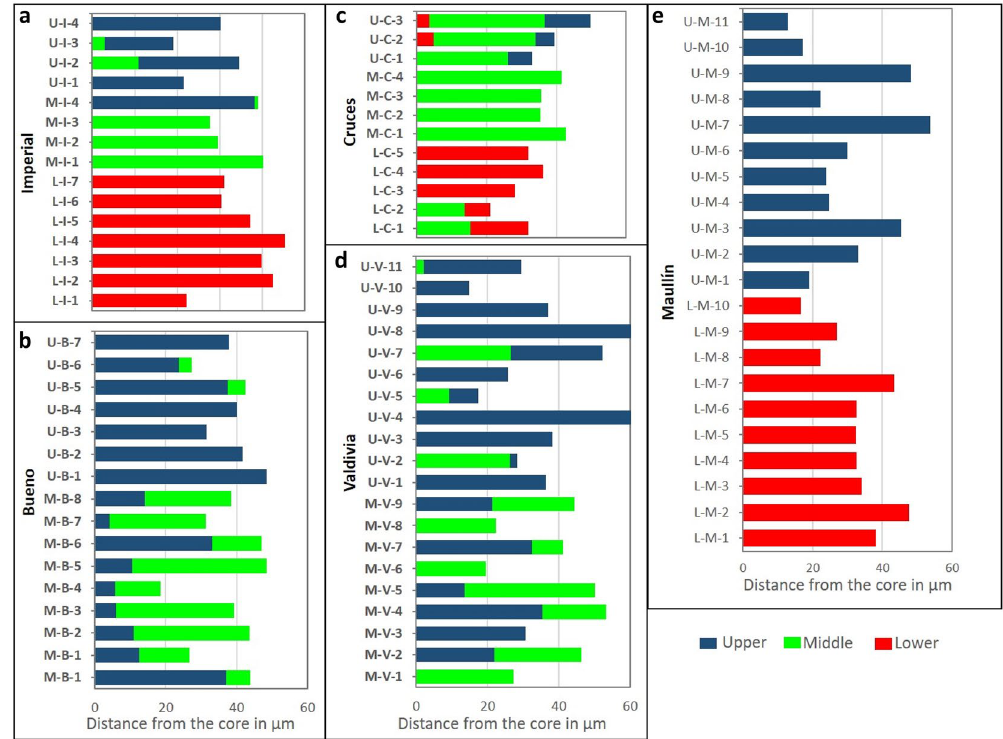
Figure 3. River section prediction for fish from each river systems ( a Imperial River, b Bueno River, c Cruces River, d Valdivia River; e Maullín River). Each bar represent an otolith transect, going from the core (emergence) to the capture (death). Colour code matches the section of the river that has been predicted by the Random Forest model for each partition of the transect. Change of colour throughout the transect indicates a movement occurring during the lifespan of the